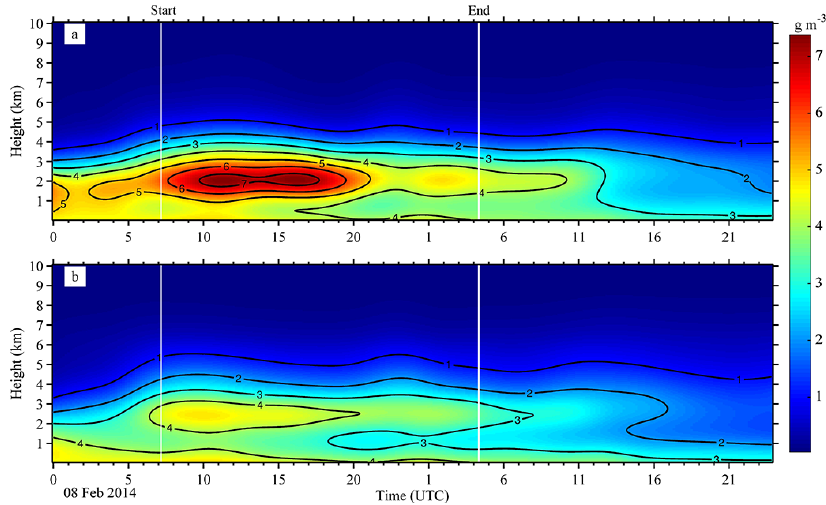
Figure 11. Same as Fig. 7 but for vapor density